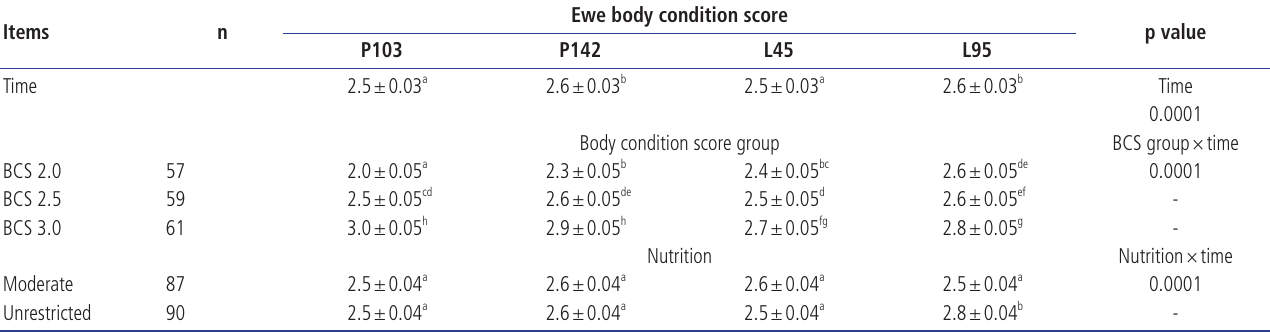
Table 2. Effect of ewe body condition score group (2.0 vs 2.5 vs 3.0) and nutritional treatment in very late pregnancy and lactation (Moderate vs Unrestricted) on ewe body condition score (mean±SEM) at P103, P142, L45, and L95